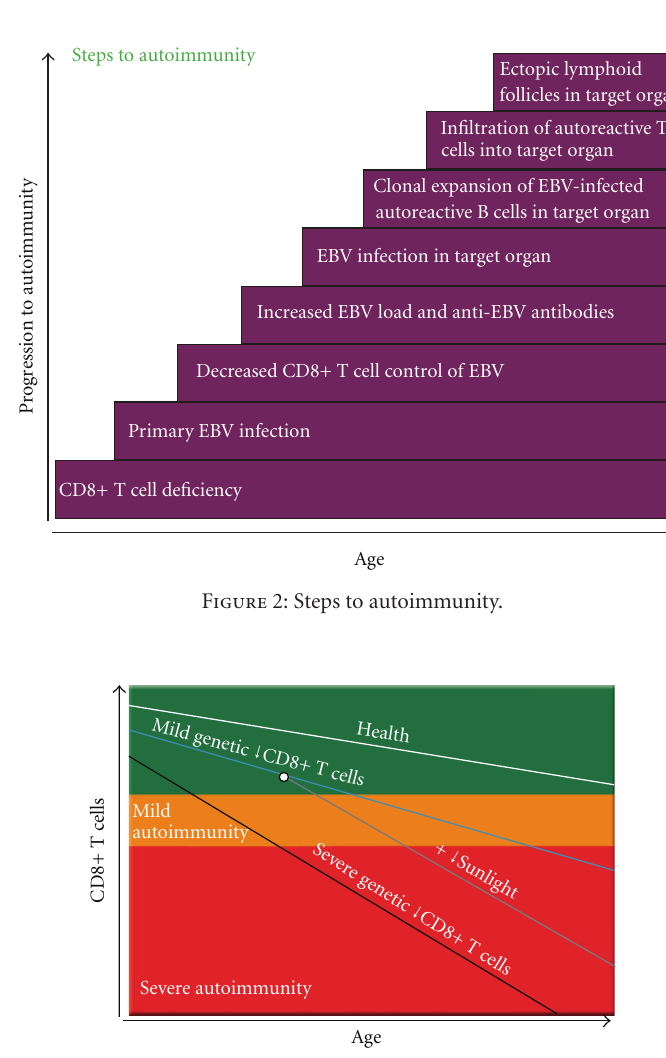
Figure 3: Proposed genetic deficiency of CD8+ T cells underlying the development of chronic autoimmune diseases. The upper green panel on the graph represents health, the middle orange panel, the development of mild autoimmune disease (mild autoimmunity) and the lower red panel the development of severe progressive autoimmune disease (Severe autoimmunity). In normal individuals (Health) the number of CD8+ T cells declines with increasing age but still remains su ffi cient to control EBV infection. In individuals with a mild genetic deficiency of CD8+ T cells, the deficiency is aggravated by increasing age eventually leading to insu ffi cient CD8+ T cells to control EBV infection. In individuals carrying HLA class II or class I genes predisposing to specific autoimmune diseases, this leads to the accumulation of EBV- infected B cells in the target organ and the development of autoimmune disease, which progresses in severity as the CD8+ T-cell count further declines with age and as the EBV load in the target organ subsequently increases. In individuals with a severe genetic deficiency of CD8+ T cells, autoimmune diseases develop at a younger age and progress more rapidly. Deprivation of sunlight and vitamin D at higher latitudes aggravates the genetic CD8+ T-cell deficiency and increases the incidence and progression of autoimmune